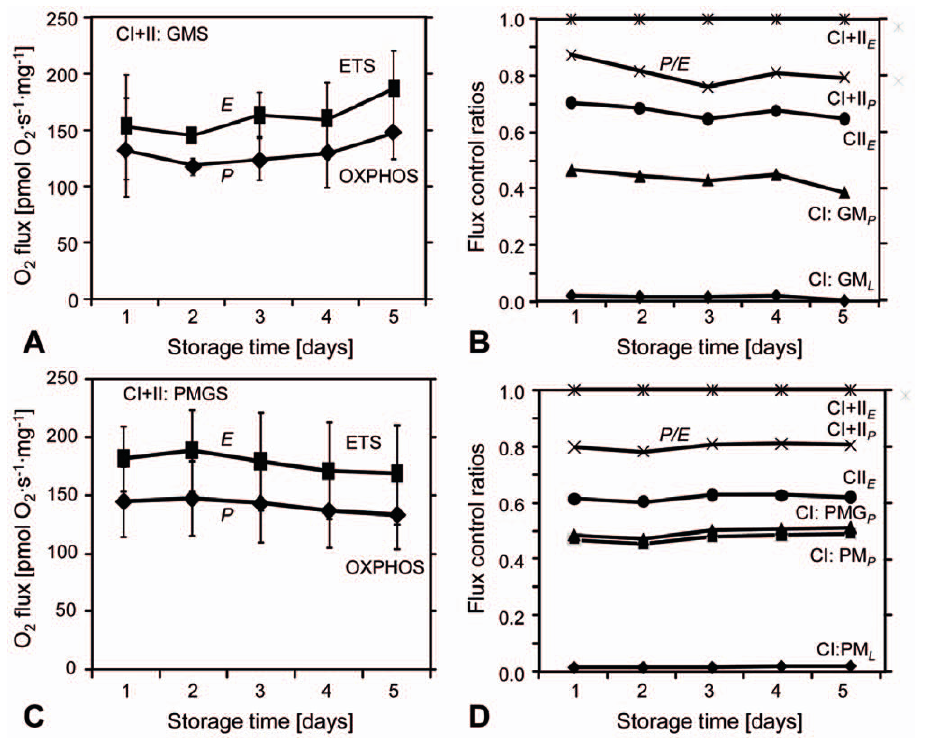
Figure 4. Preservation of respiratory capacities and flux control ratios during extended cold storage of equine skeletal muscle. OXPHOS and ETS capacity (pmol ? s 2 1 ? mg 2 1 wet weight) with CI + II electron input, and corresponding flux control ratios, with protocol SUIT1 ( A and B ) and SUIT2 ( C and D ). Non-significant changes over a period of 5 days. Each symbol is the mean value 6 SD ( n =2) for the N =3 horses sampled. All flux control ratios were normalized for CI + II E